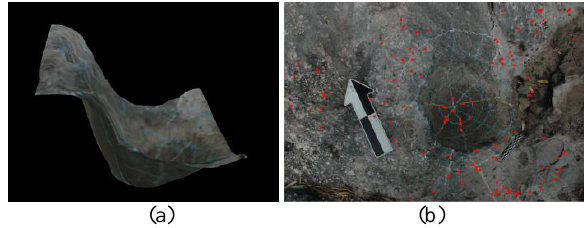
Figure 8. The reconstructed surface with texture in (a), whereas for comparison, a set of match points generated by the SIFT algorithm is presented in